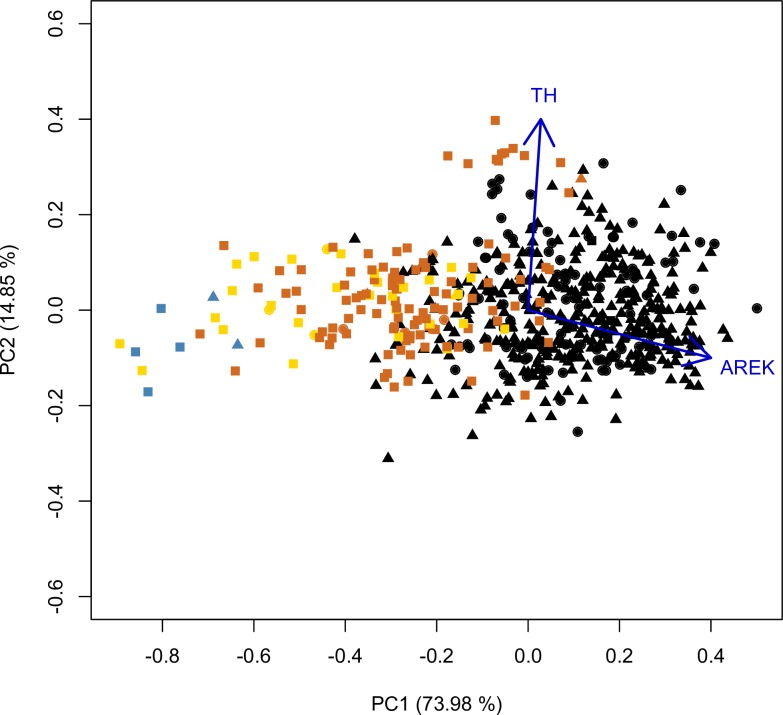
PCA of archaeological and modern kernels for five traits.First two PCA axes accumulate 88.83% of the total variance. Blue dots represent archaeological kernels from Pintados 1307, yellow dots represent archaeological kernels from Tarapacá 13, orange dots represent archaeological kernels from Tarapacá Viejo, and black dots represent modern kernels. Kernels from Pintados 1307 (Formative Period) are grouped with Tarapacá 13 kernels (Late Intermediate Period-Late Period), while Tarapacá Viejo (Late Period) and modern kernel specimens are distant from the previous ones. AREK = Area of the kernel; TH = Thickness., Circles correspond to individuals assigned to genetic cluster 1 in Structure analysis, triangles correspond to individuals assigned to genetic cluster 2 and squares correspond to individuals with no genetic information.